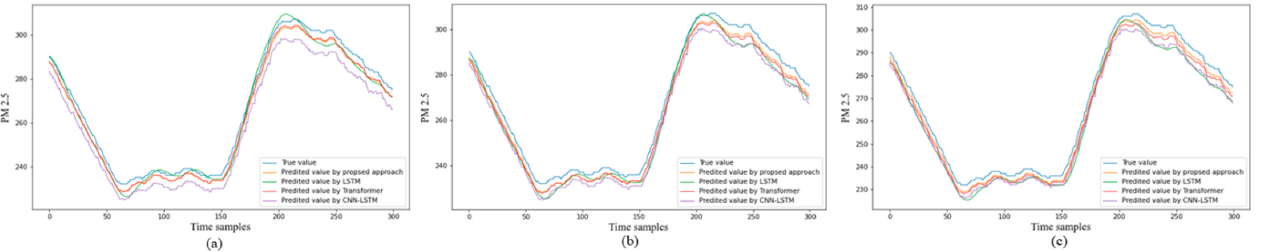
Figure 8. Fitting trends of model for 5 min ahead prediction for ( a ) 20 epochs, ( b ) 30 epochs, ( c ) 40 epochs.